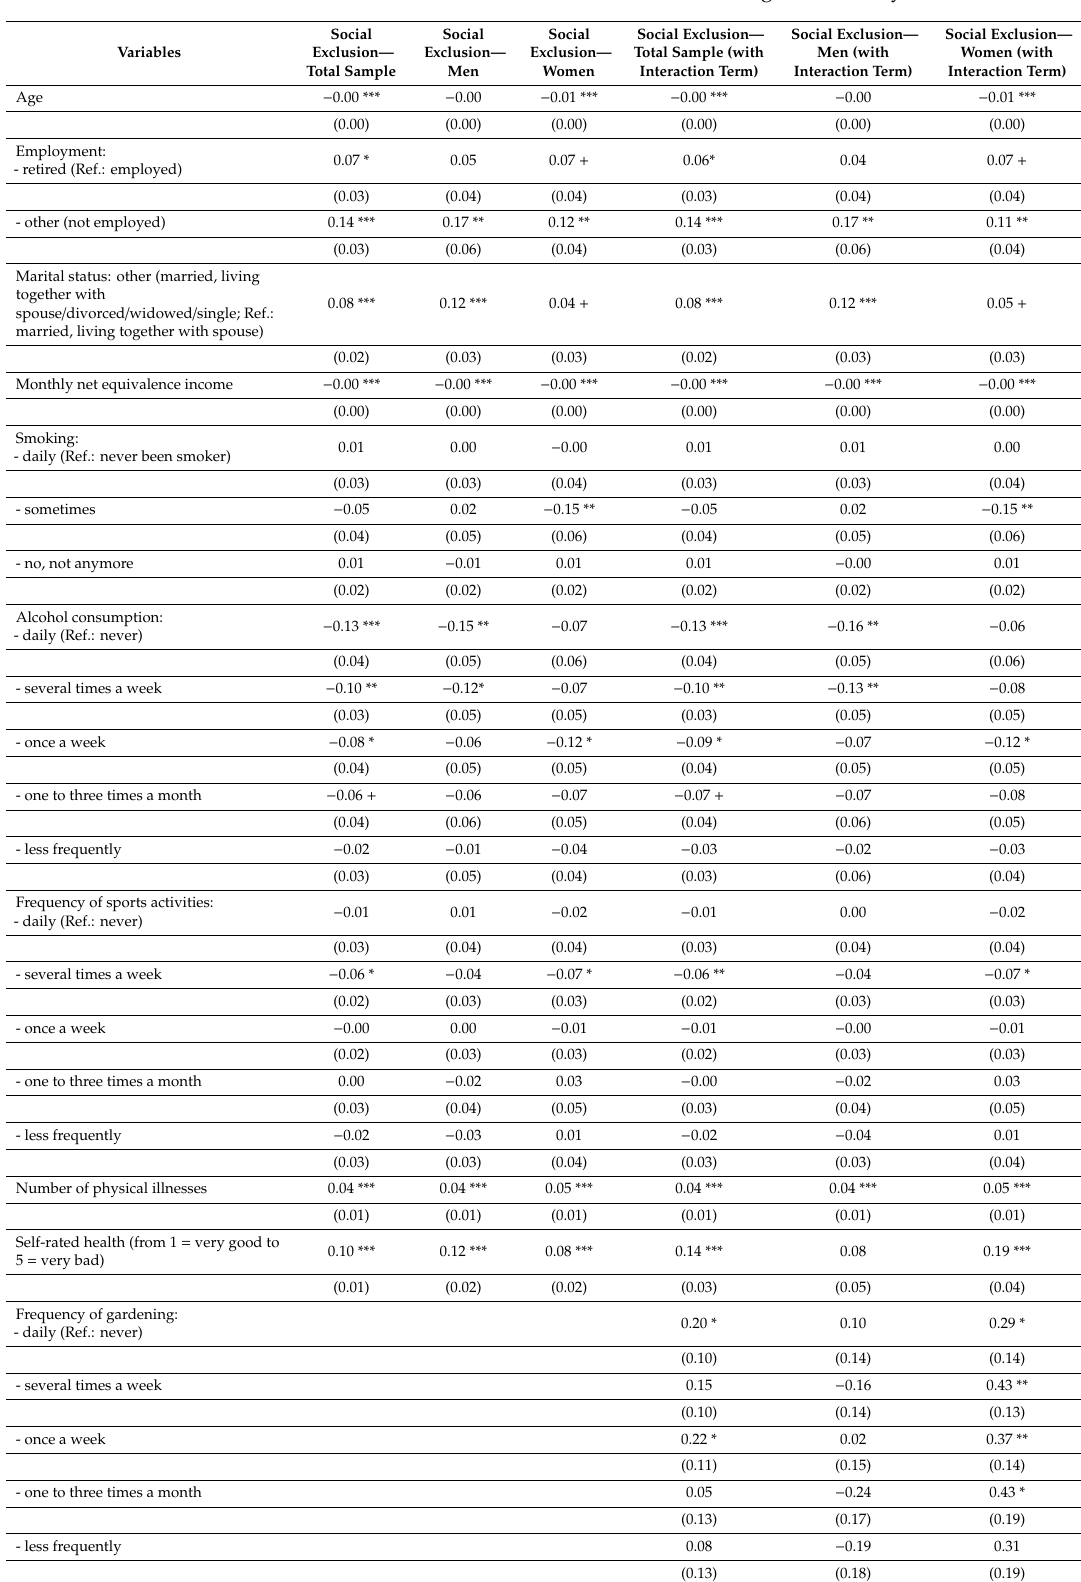
Table 2. Determinants of social exclusion. Results of linear regression analysis. Variables